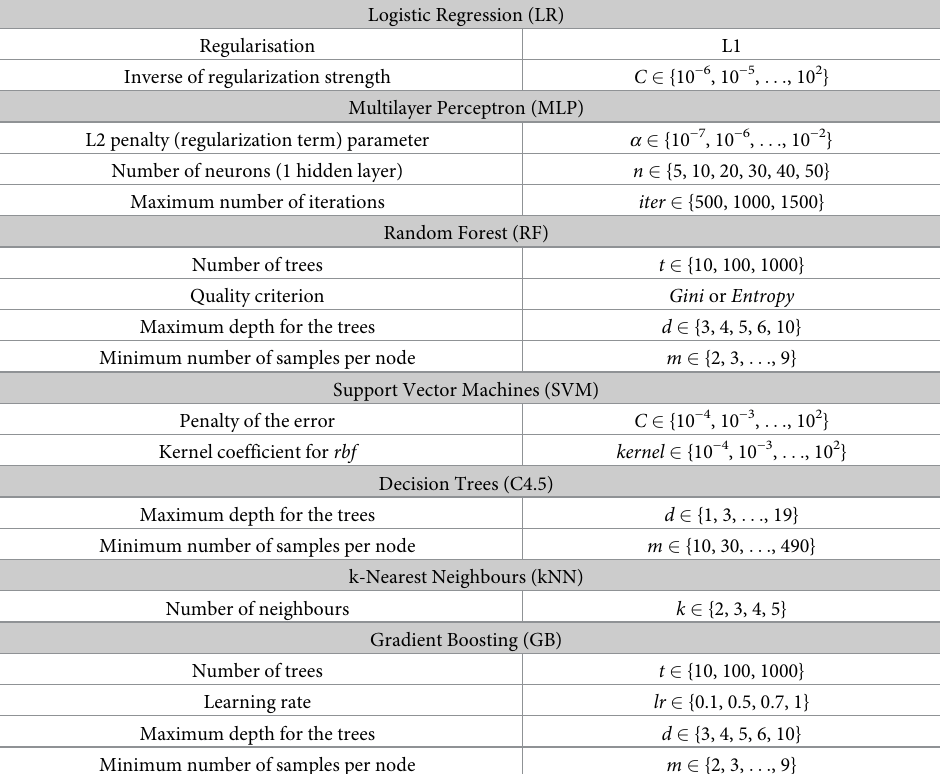
Table 3. Parameters used during the model selection. NB does not involve parameters to be